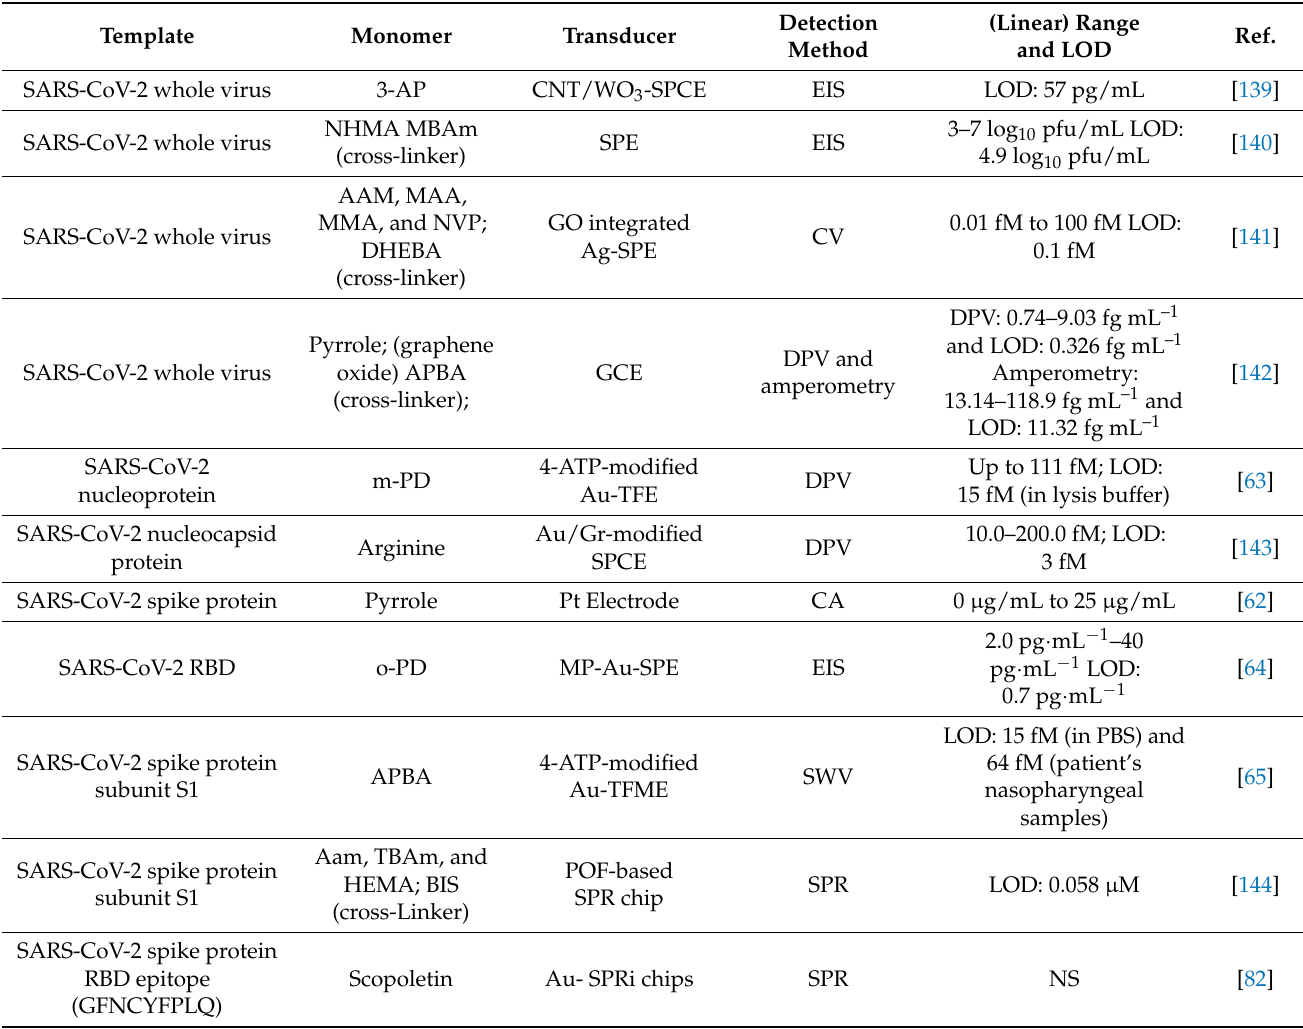
Table 1. MIP-based biomimetic sensors for SARS-CoV-2